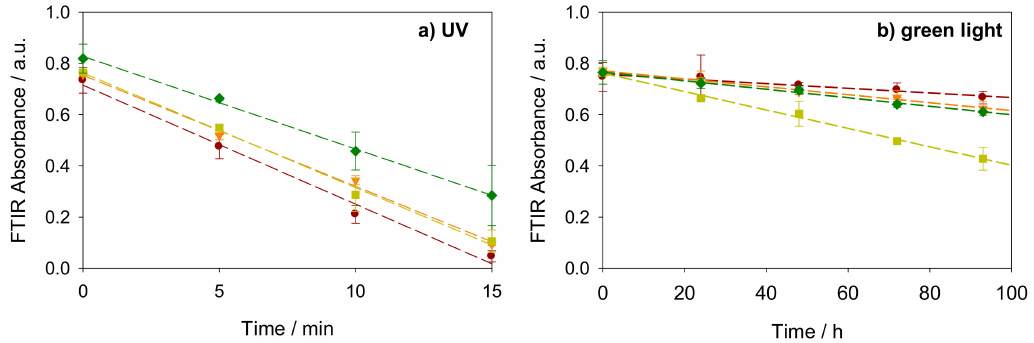
Figure 3. Evolution of integrated FTIR absorbance of stearic acid between 2800 to 3000 cm − 1 as a function of illumination time on the sample of pristine TiO 2 P25 film (red ) and Au cluster modified TiO 2 P25 films with 2 ML (orange (cid:72) ), 4 ML (yellow (cid:4) ) and 8 ML (green (cid:7) ) Au coverages under ( a ) UV and ( b ) green light illumination.